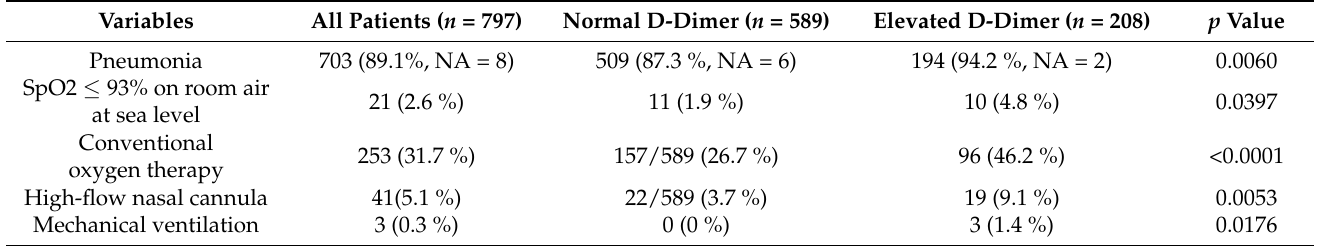
Table 2. Analysis of respiratory status on admission by classifying D-dimer